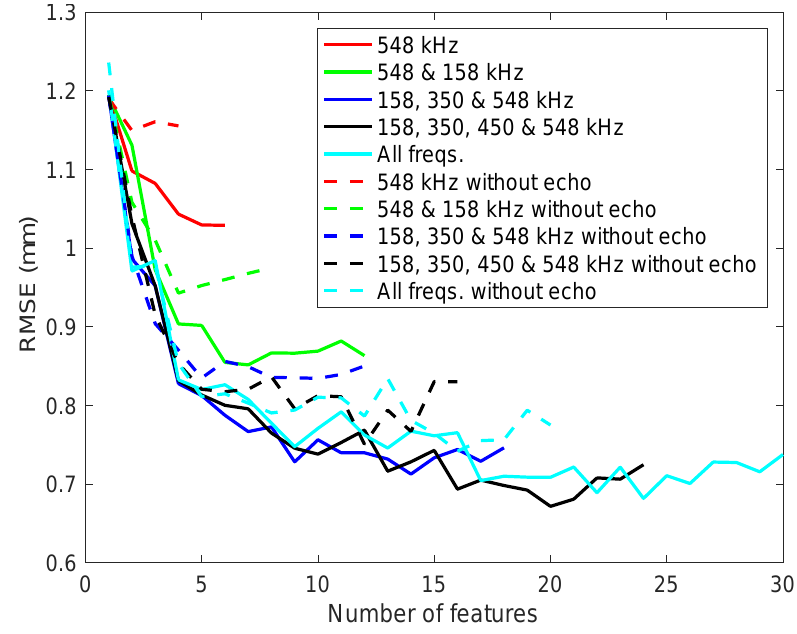
Figure 10. RMSE obtained with neural networks predictor depending on the number of features selected at different